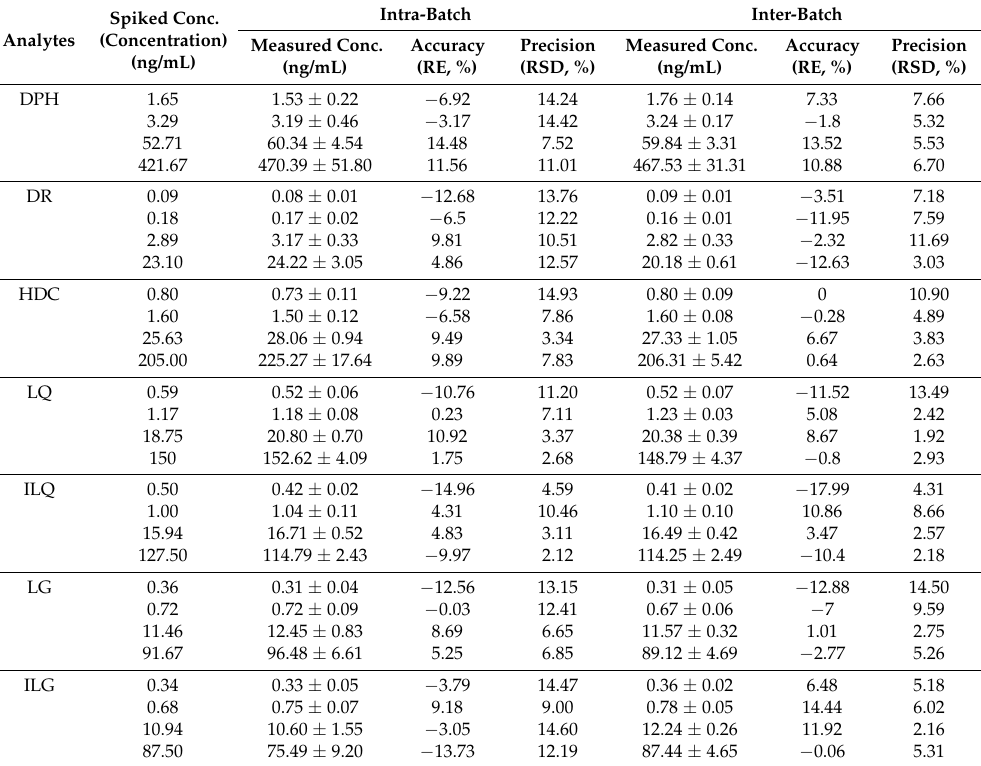
Table 2. Intra-batch and inter-batch accuracy and precision of LC-MS/MS determination of DPH, DR, HDC, LQ, ILQ, LG, ILG, GL, and GA in rat